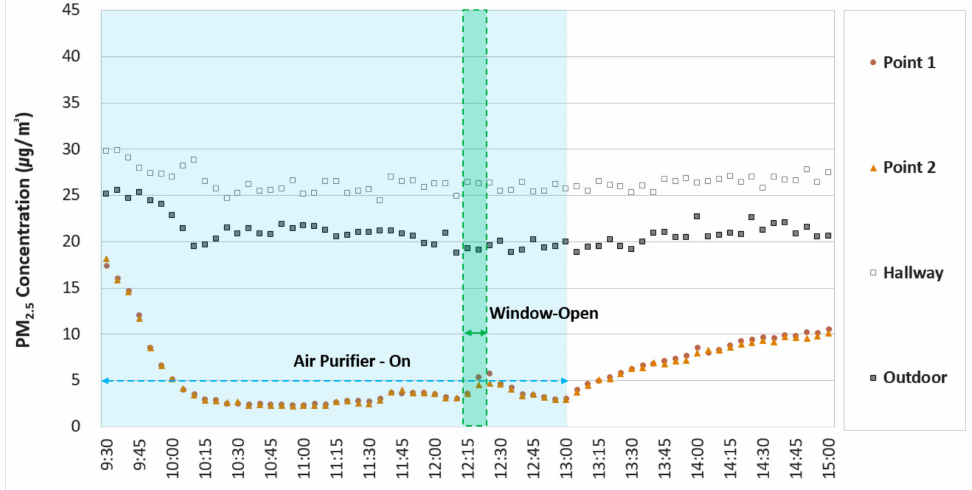
Figure 8. PM 2.5 and CO 2 concentration test results for a 48.73 m 2 office space on 20 August